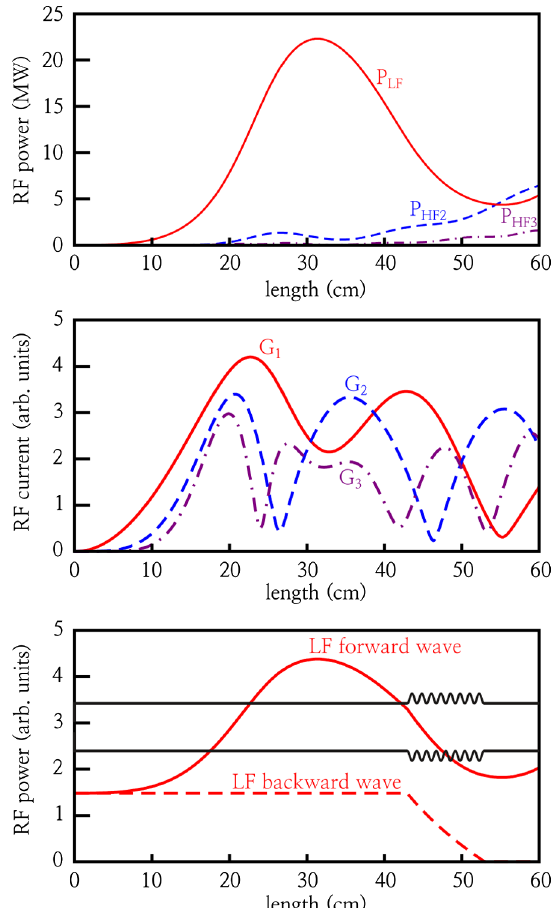
FIG. 3. The results of simulations of the FEM multiplier based on LIU-3000 within the framework of the averaged approach. Dependences on the axial coordinate z of (a) the LF power ( P LF ) and HF powers P HF 2 ; 3 at the second ( P HF 2 ) and third ( P HF 3 ) harmonics, (b) amplitudes of the rf current harmonics ( G i ) and (c) amplitudes of the forward- and backward-propagating LF waves with respect to the position of the Bragg